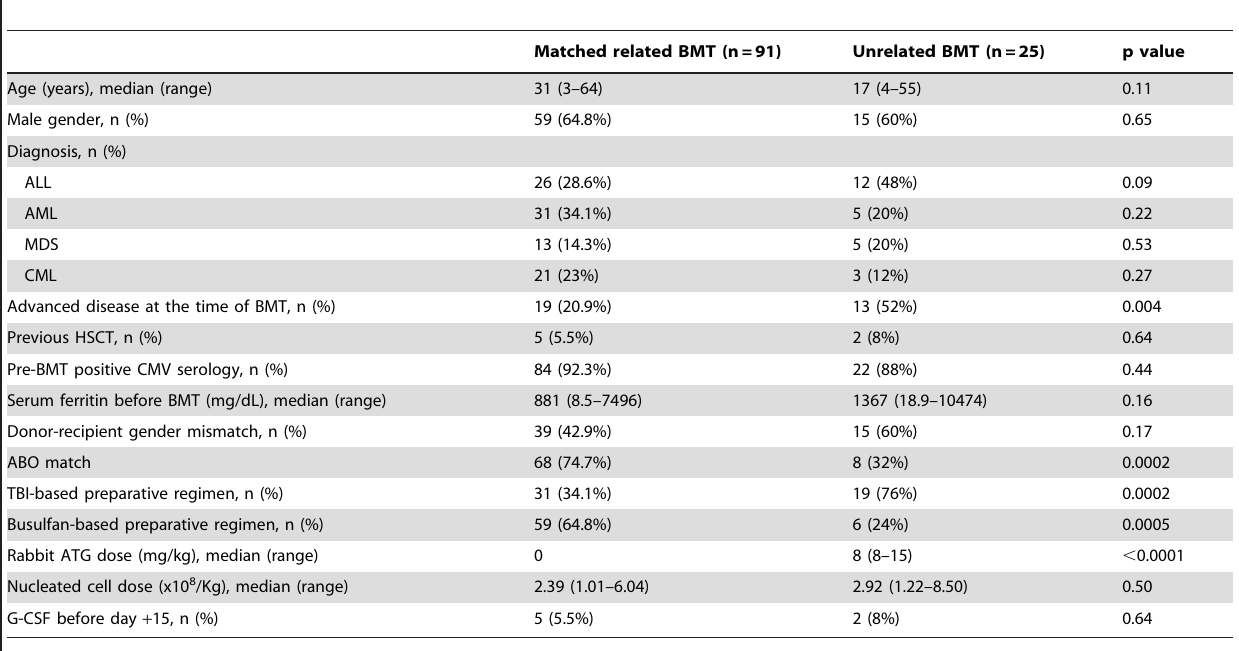
Table 1. Comparison of baseline characteristics between matched related and unrelated